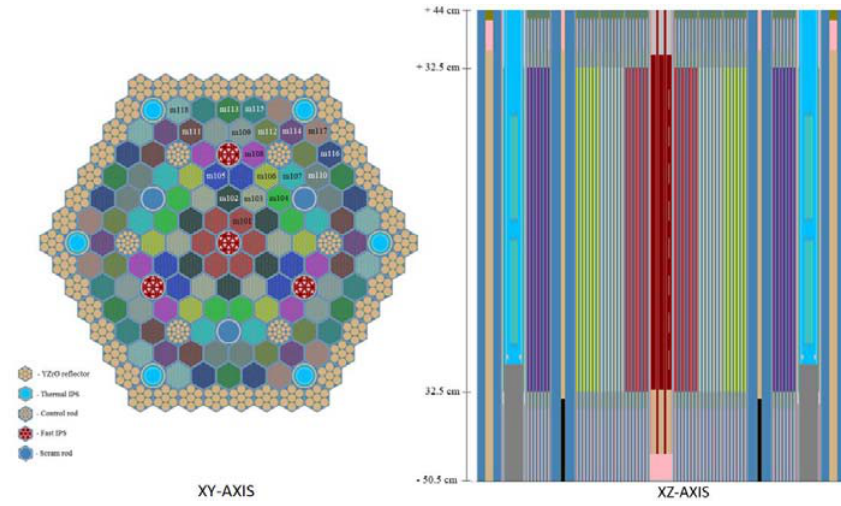
Figure 2. Reduced MYRRHA-1.6 based-model in OpenMC